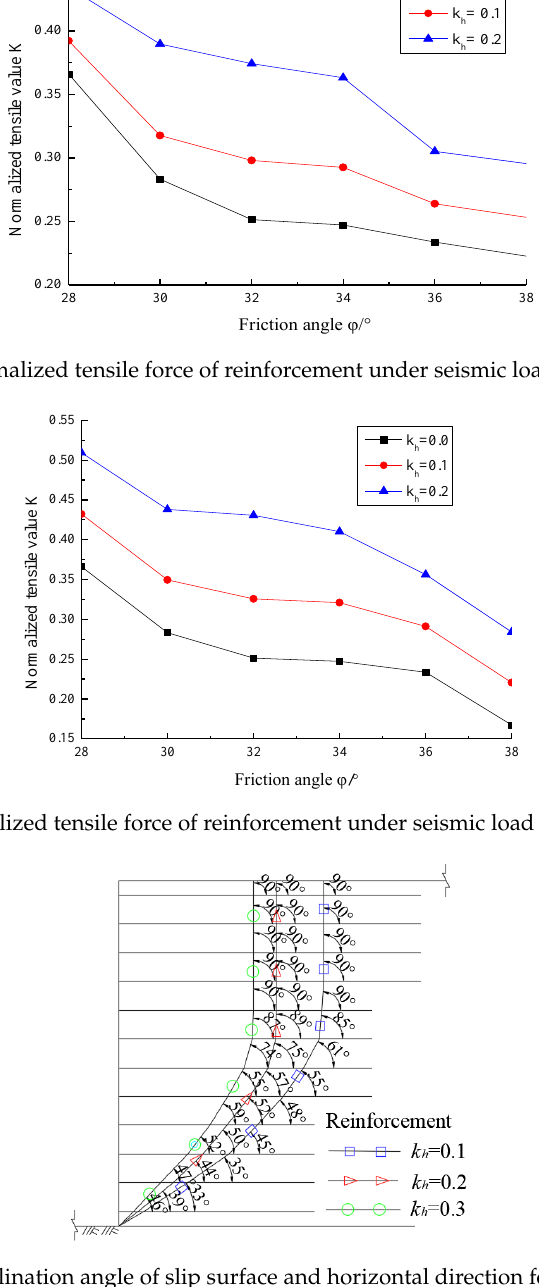
Figure 7. Effect of cohesion on normalized tensile force of reinforcement. 5